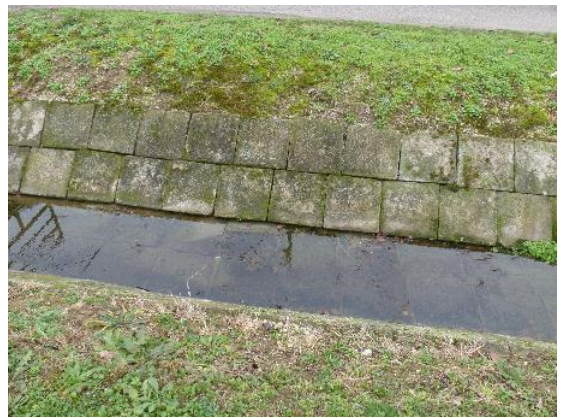
Figure 4. Lopašov Flow—modified watercourse (Moyzeová, 2020).